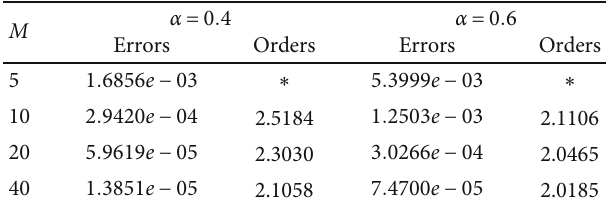
Table 1: The errors and convergence orders in temporal direction by using Q-FEM. α = 0 : 4 α = 0 : 6 M Errors Orders Errors